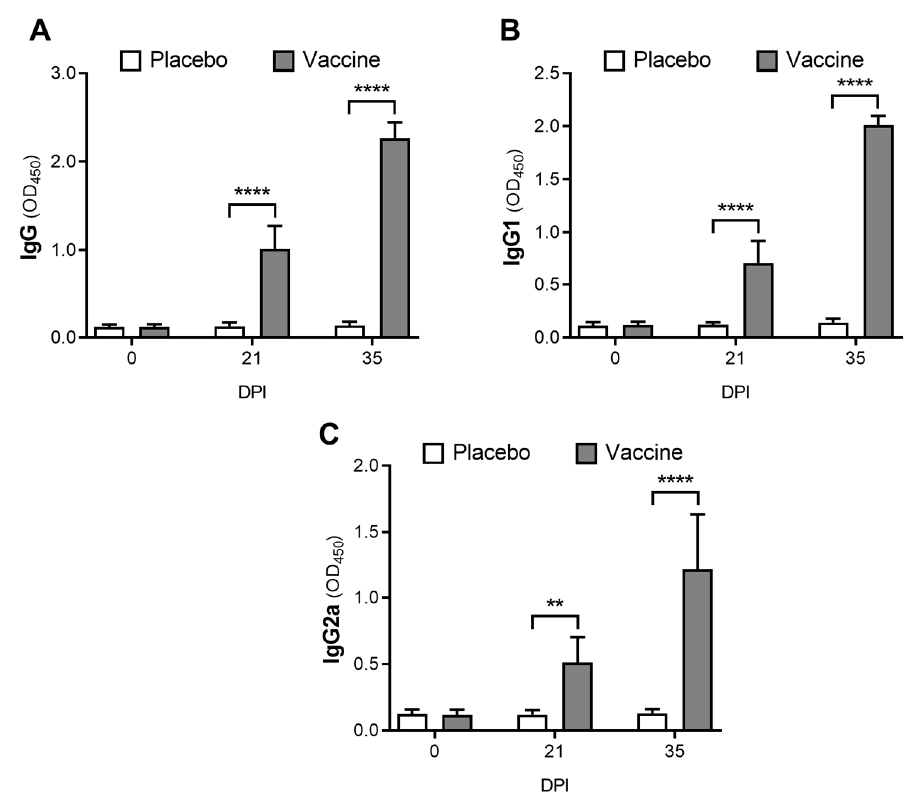
Figure 3. Proteoliposome-based vaccine increases sera levels of IgG, IgG1 and IgG2a against the bacteria. Total IgG ( A ), IgG1 ( B ), and IgG2a ( C ) immunoglobulins against E. coli were quantified in the serum of vaccinated and placebo mice, on days 0, 21, and 35, by indirect ELISA assays. Results correspond to means ± SD, n = 8. ** = p < 0.01; **** = p < 0.0001.